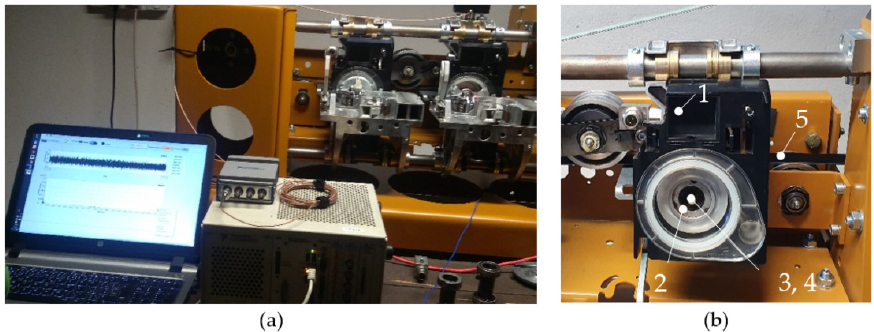
Figure 1. ( a ) Testing station and part of the measuring chain components; ( b ) the spinning unit 1, rotor housing body 2, rotor 3, absorber 4, and flat belt 5.